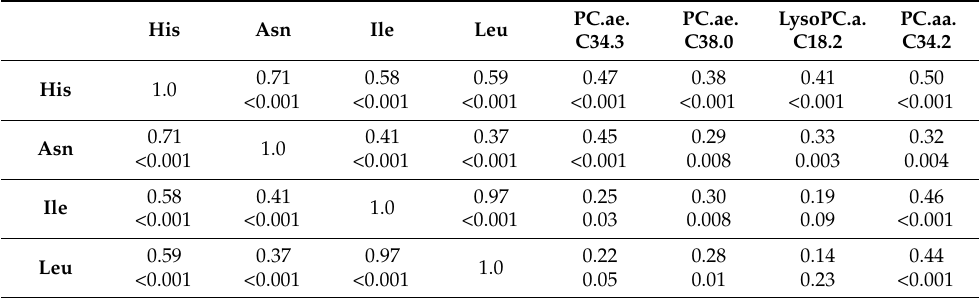
Table 4. Correlation matrix of metabolites of controls (with r- and p